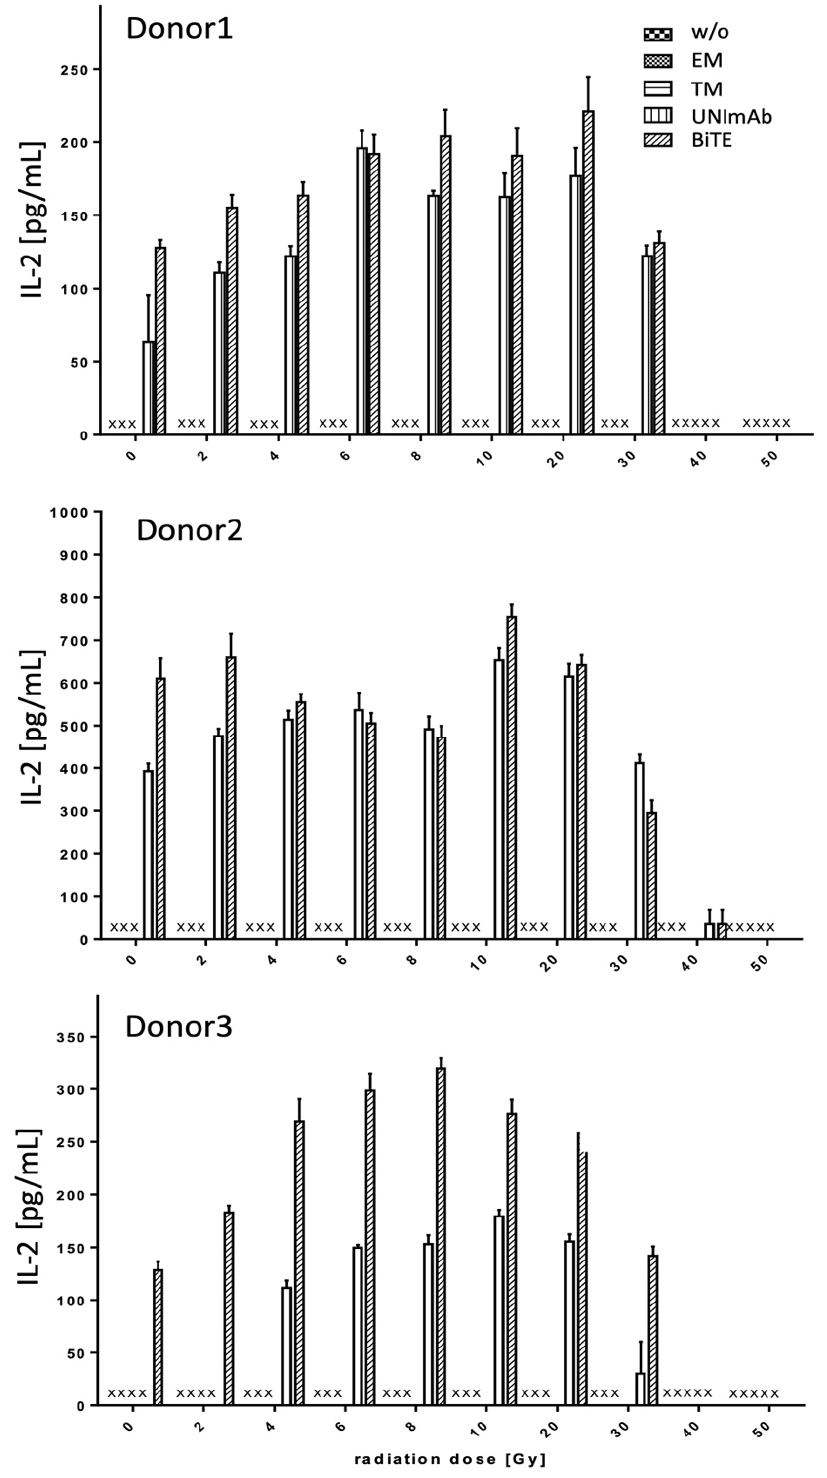
Figure 5. Release of Interleukin 2 (IL-2). The concentrations of IL-2 were measured in supernatants via ELISA. The mean cytokine concentrations ± SD of triplicates for three different donors are shown. (x… not detectable).